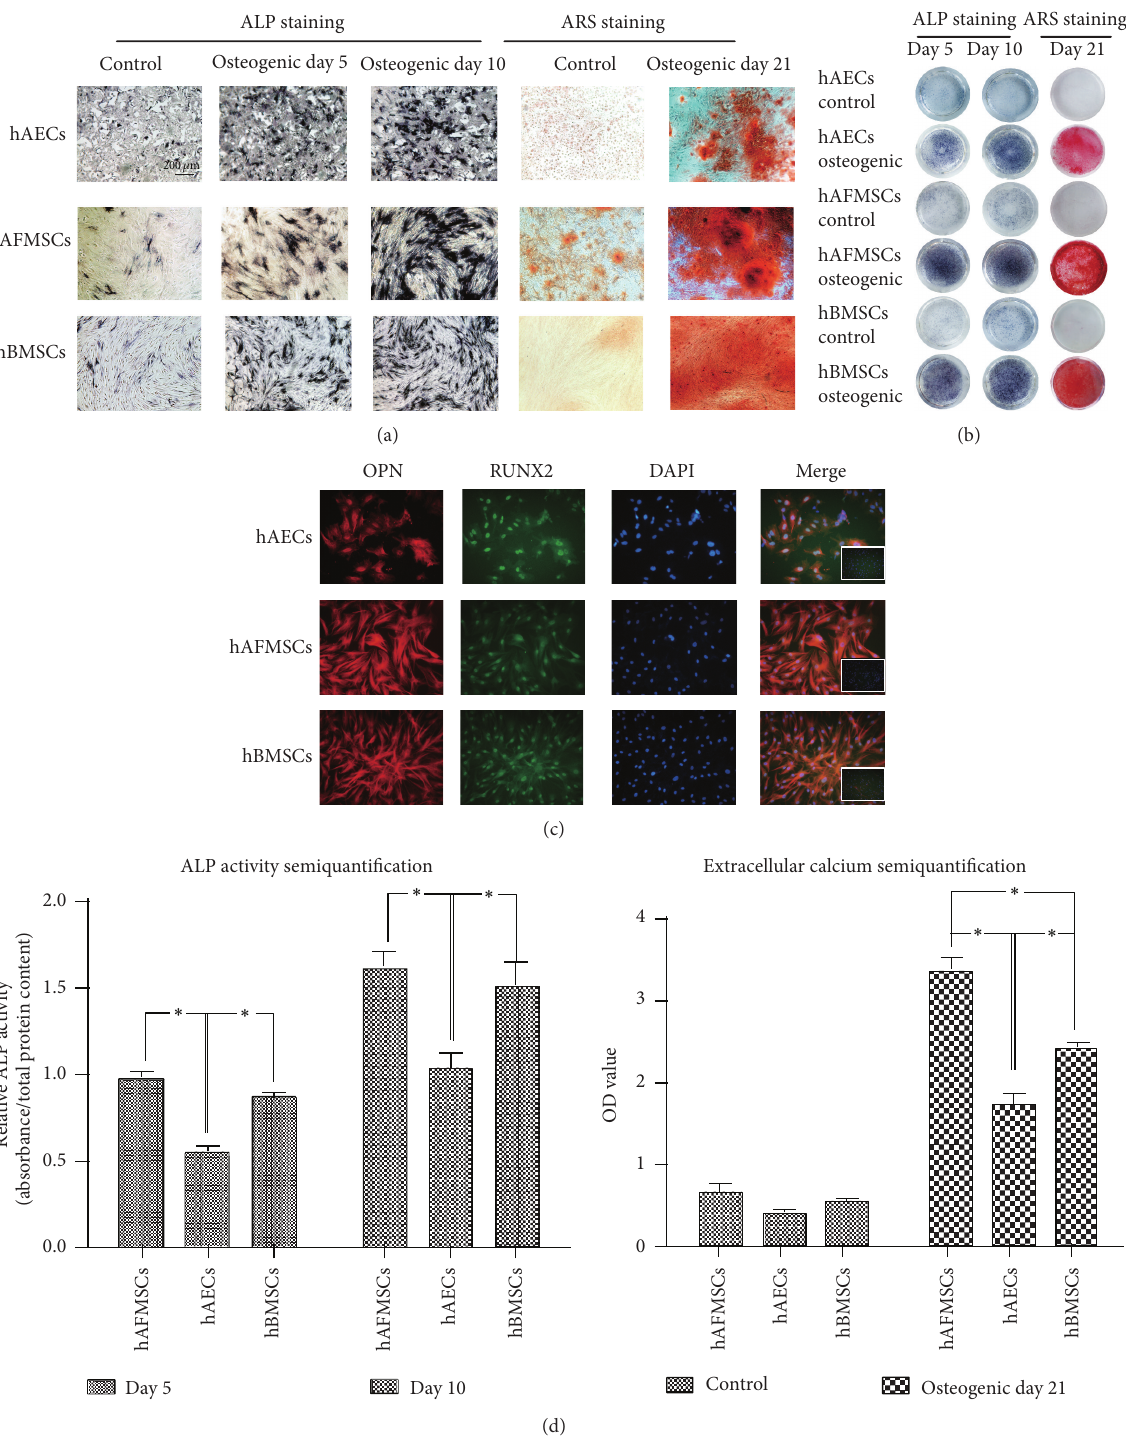
Figure 2: hAECs show a confirmed though relative lower osteoblastic capacity in vitro . (a, b) Progressively increased cellular ALP and ARS staining after osteogenic induction were observed in all cell types. (c) Immunofluorescence labeling of Runx2 (FITC, green), OPN (Cy3, red), andNucleus(DAPI,blue)inhAECs,hBMSCs,andhAFMSCsfollowingthe10-dayosteogenicinductionexhibitedamoreintensefluorescence of OPN and clear nuclei-localization of RUNX2 (small images at the corner of the merged images indicated the merged images of control group). (d) Further semiquantification of ALP activity and extracellular mineralization showed the lowest cellular ALP activity and mineral producing efficiency in hAECs group while hAFMSCs exhibited the highest level of extracellular mineralization (c; ∗ : 𝑃 < 0.05